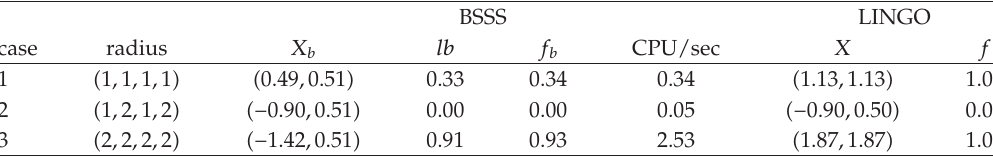
Figure 4: Two di ff erent perspectives of objective function for third case of Example 4.2. Table 1: The results of Example 4.2.